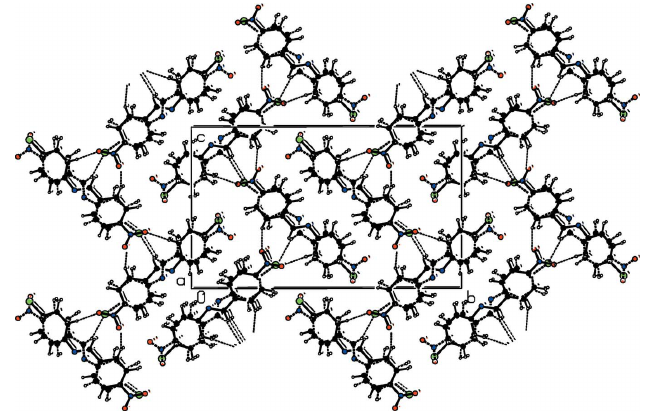
Figure 4 A view along the a axis of the crystal packing of CNBA. The hydrogen bonds (see Table 1) are shown as dashed lines.